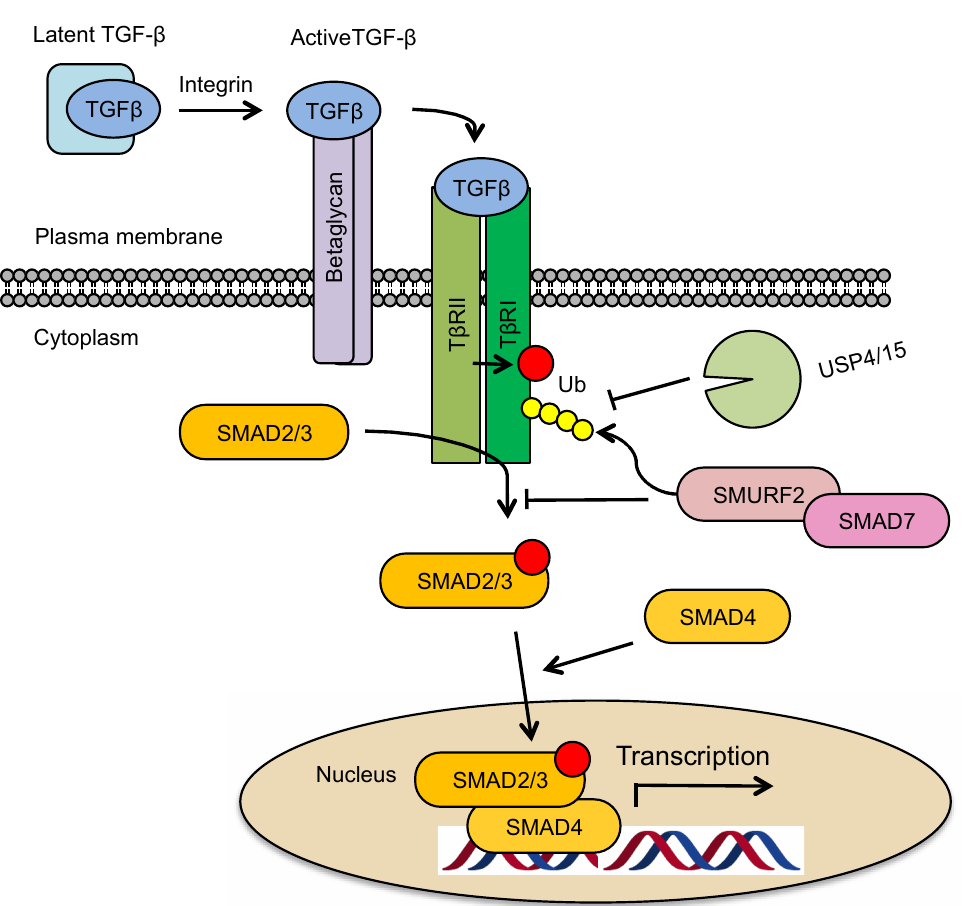
Figure 1. Schematic representation of transforming growth factor (TGF)- β / SMAD signaling. TGF- β is secreted in a latent form, which can be activated via integrin-dependent processes. Activated TGF- β initially engages with co-receptor beta glycan. Thereafter, it is passed on to T β RII that recruits T β RI forming a heteromeric signaling complex. Upon T β R1 phosphorylation and activation by T β RII kinase (phosphorylation indicated with red circle), SMAD2 and SMAD3 are phosphorylated (phosphorylation indicated with red circle) and form complexes with SMAD4. These complexes translocate into nucleus and act as transcription factors to regulate the expression of TGF- β signaling target genes. SMAD7, together with E3 ubiquitin ligase SMURF2, can induce proteasomal / lysosomal degradation of T β RI. This process can be reverted via the action of USP4 / 15 deubiquitinating enzymes.